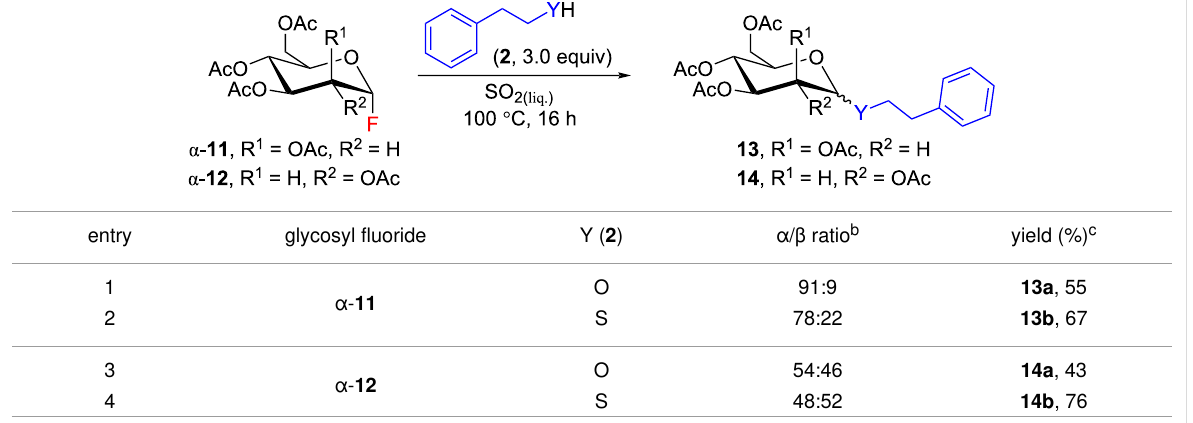
tures (Scheme 4). The reaction temperature for mannosyl fluo- ride α - 15 was optimized to 30 °C (Table S5, Supporting Infor- mation File 1). At higher temperature desired mannoside